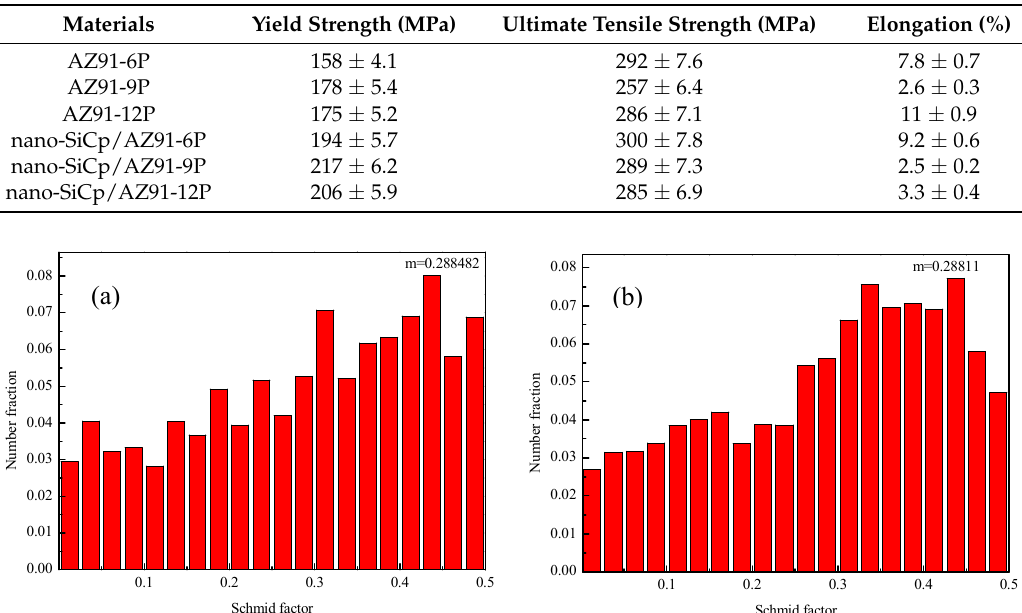
Figure 9. SEM images of fracture surface after multi-pass forging for 12 passes: ( a )( c ) AZ91 alloy and ( b )( d ) nano-SiCp/AZ91 composites. 3.3. A ffe cting Factors for the Strength-Toughness Properties of the Nano-SiCp/AZ91 Composites According to the research regarding on the microstructure and mechanical properties of the AZ91 alloy and nano-SiCp/AZ91 composite, the strength-toughness properties of the composites at room temperature are affected by the matrix grain size, texture evolution, SiC nanoparticles distribution and the precipitated second phases. Since all the above affecting factors are interactive, it is necessary to give a comprehensive discussion of these influences on the mechanical properties. 3.3.1. Effect of Grain Size on the Strength-Toughness Properties